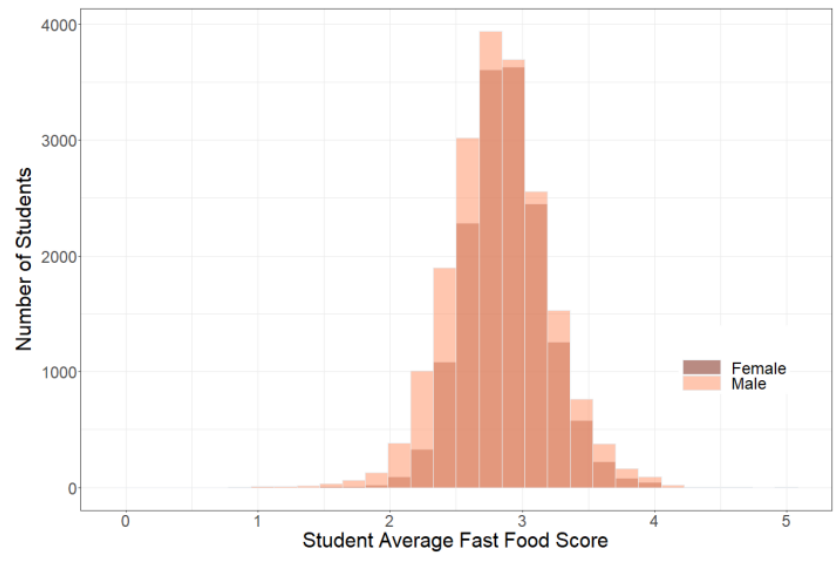
Figure 1. Student Average Fast-food Health Food and Beverage Score by Sex, N = 35,449.